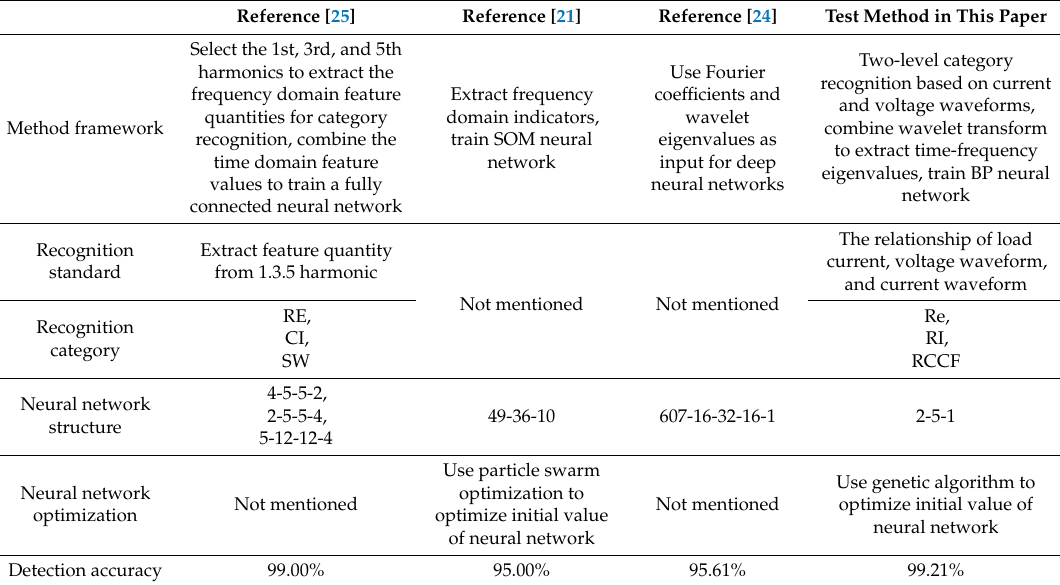
Table 8. Comparison of detection methods.